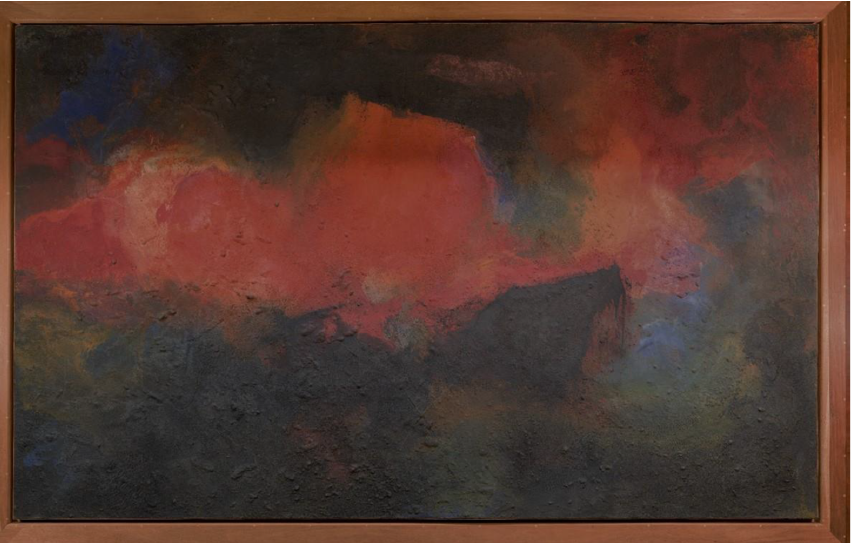
Figure 1. Photo of Paisaje Abstracto by Rafael Coronel after intervention. Photo: D.R. ©Digital Archive of the Collections of the National Museum of Anthropology, INAH, Canon, 2018.